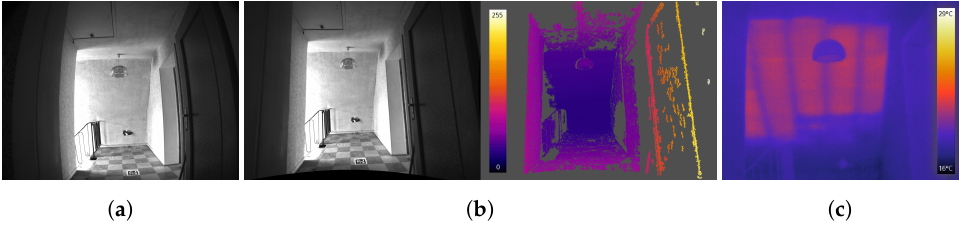
Figure 7. ( a ) Left IPS camera image. ( b ) Rectified left image and color coded disparity image generated by SGM (color bar with disparities values (gray values = no data)). ( c ) IR sensor image (color bar with temperature